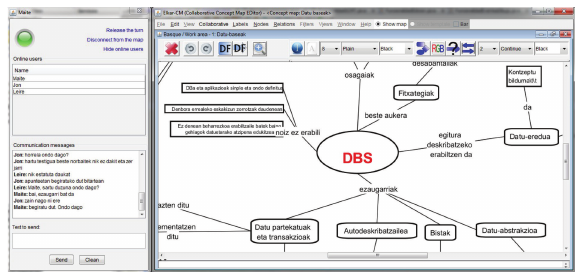
Figure 1: Collaboration process using